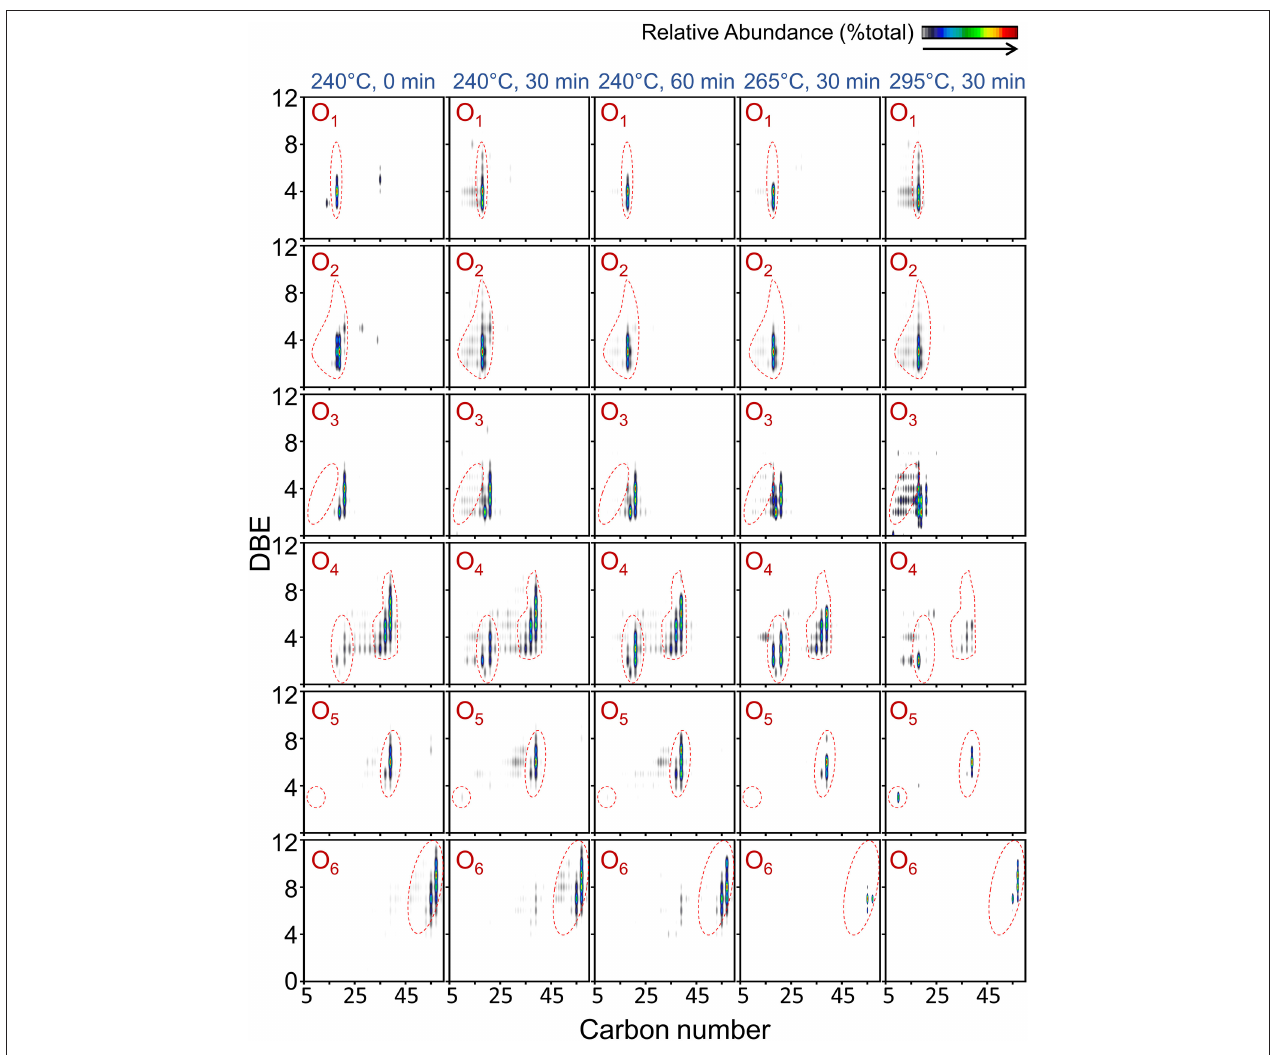
FIGURE 6 | Color-coded isoabundance contour plots for the O-containing heteroatom classes of compounds in bio-crude oil obtained at different HTL temperature and reaction time conditions observed by positive-ion APPI FT-ICR